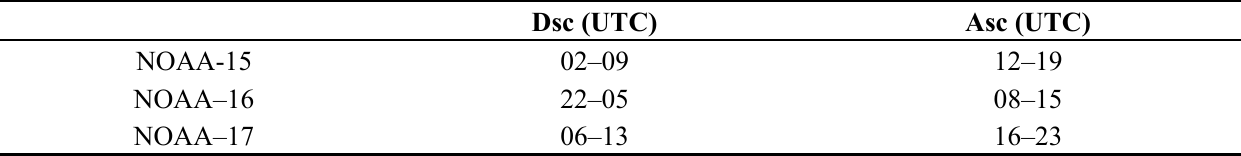
Table 1. Time intervals considered for the descending and ascending satellite passes for each platform (NOAA-15, 16 and 17) to cover the Mediterranean region (25°–60°N,